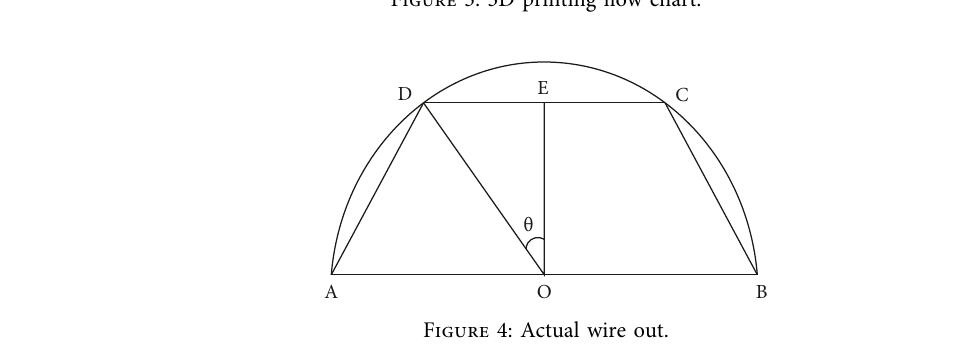
Figure 3: 3D printing flow chart.